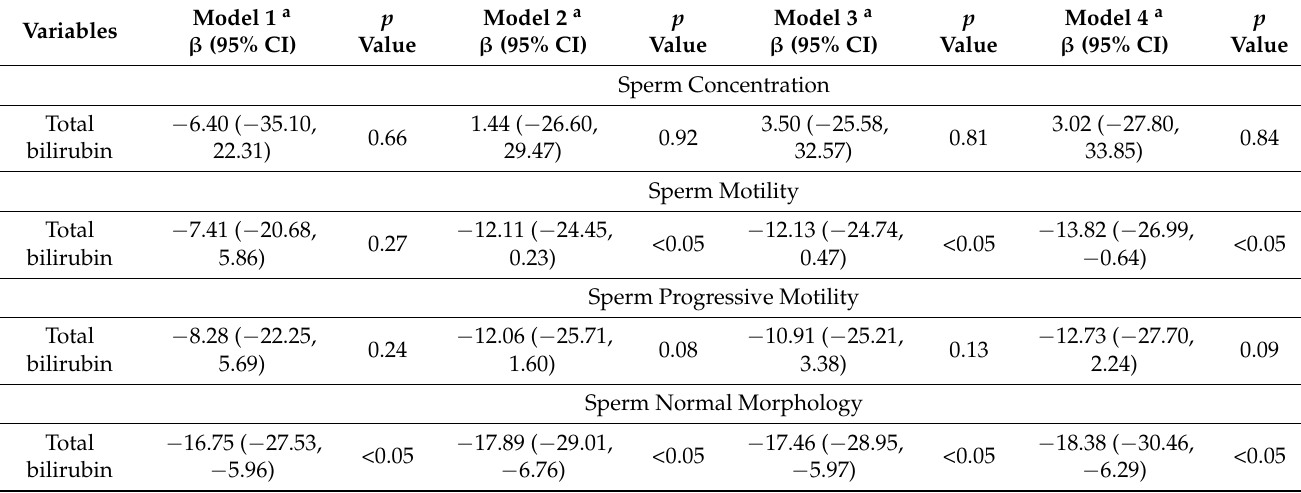
Table 2. Association between serum total bilirubin and sperm quality.